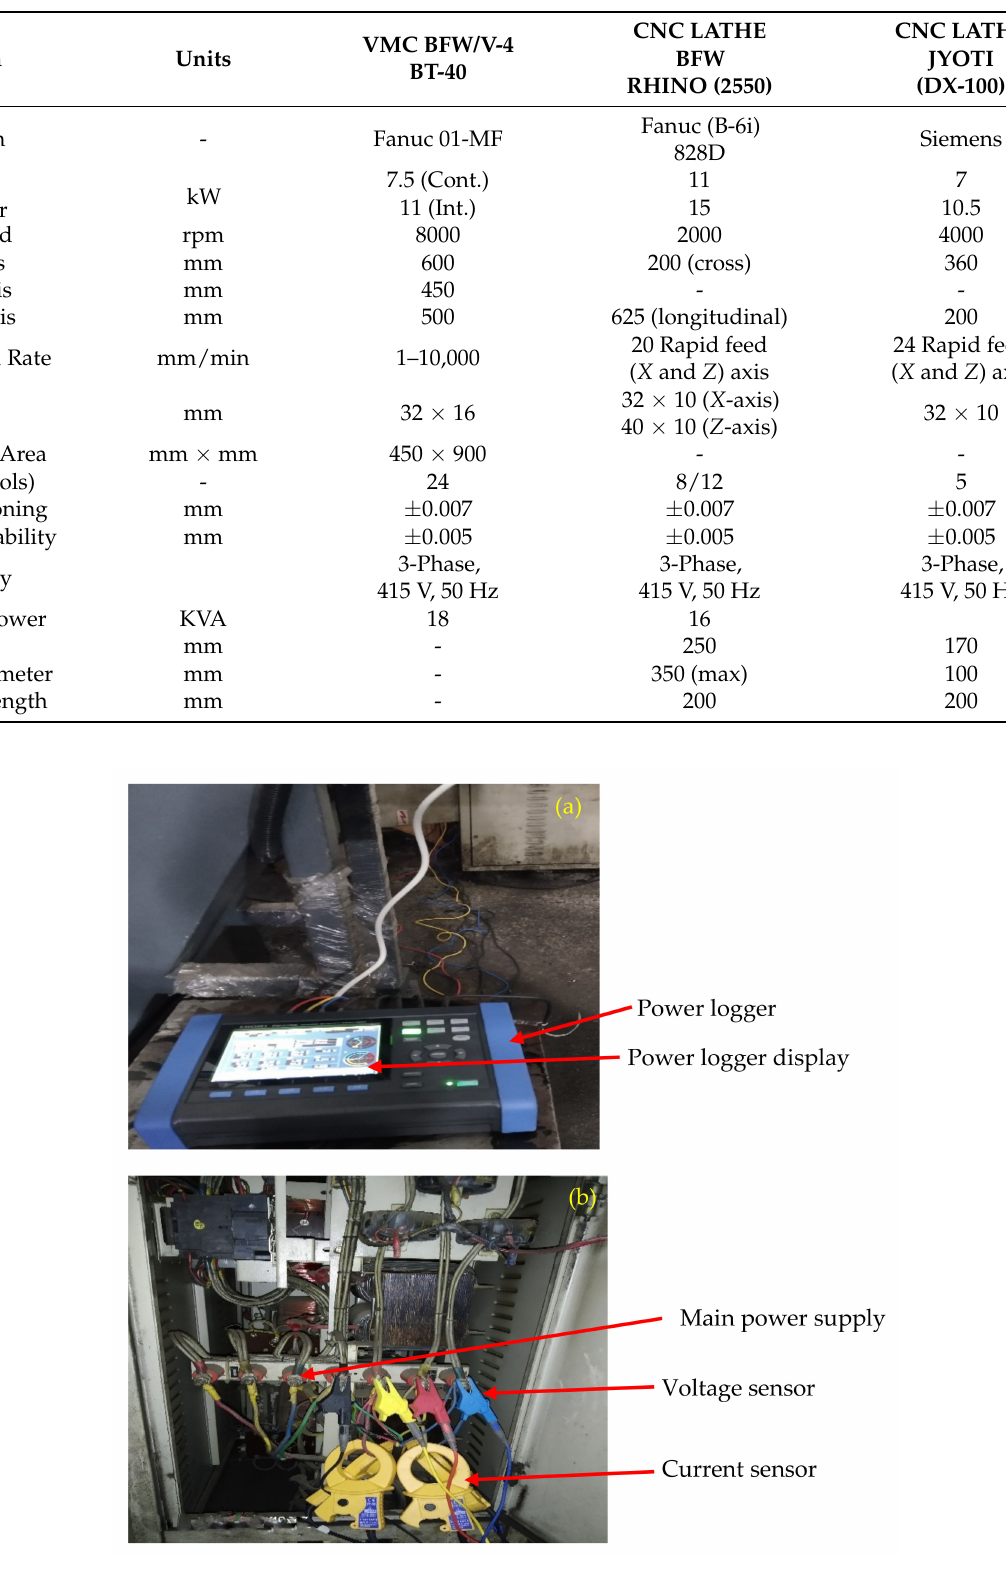
Table 4. Technical specifications of machine tool